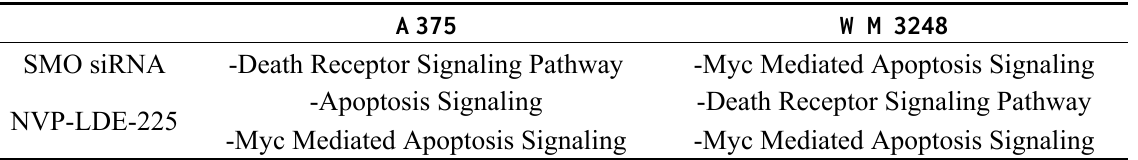
Table 1. Genetic and Pharmacologic Inhibition of SMO upregulates apoptosis signaling. Both SMO siRNA and NVP-LDE-225 upregulate apoptosis pathways in WM3248 and A375 cell